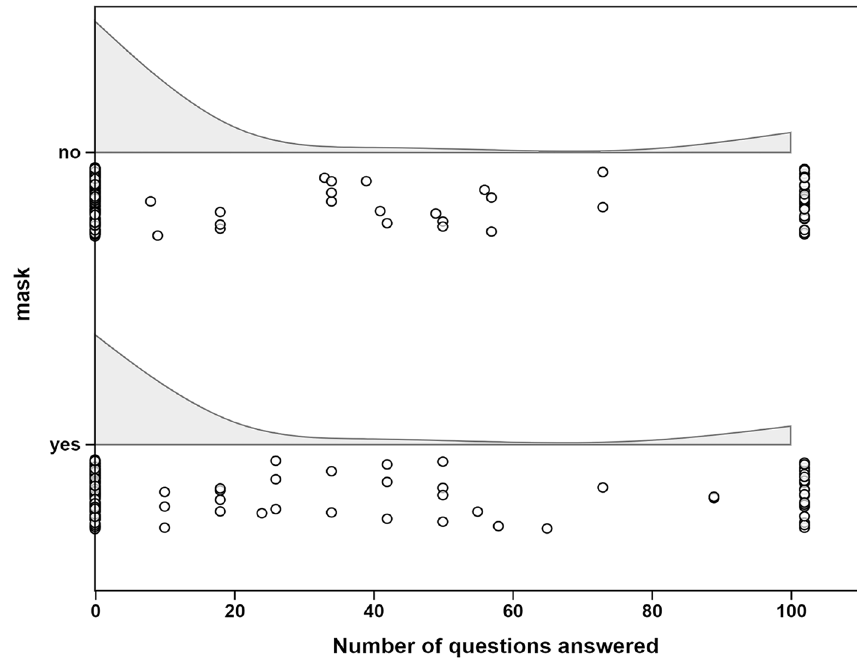
Figure 1. Raincloud plots of prosocial measure scores for the two